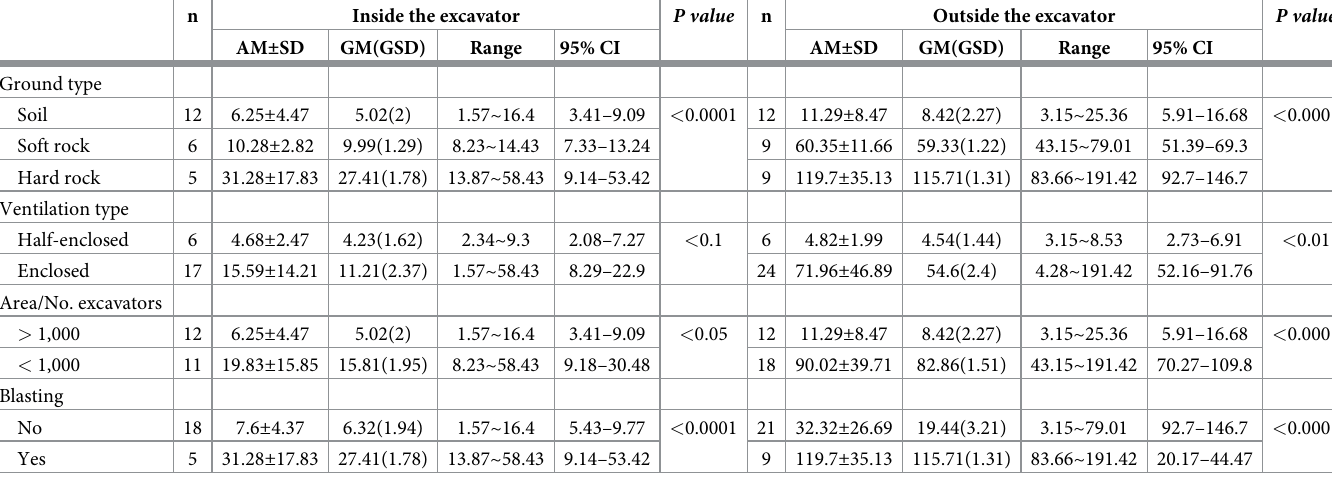
Table 4 and Fig 3 shows the concentration of total PAHs and 16 sub-compounds of PAHs from inside and outside the excavators in underground excavation sites. The concentration was calculated by summing the concentrations detected in the filter and XAD-2 tube. The GM Table 3. Concentration of respirable EC by environmental variables (unit: μ g/m 3